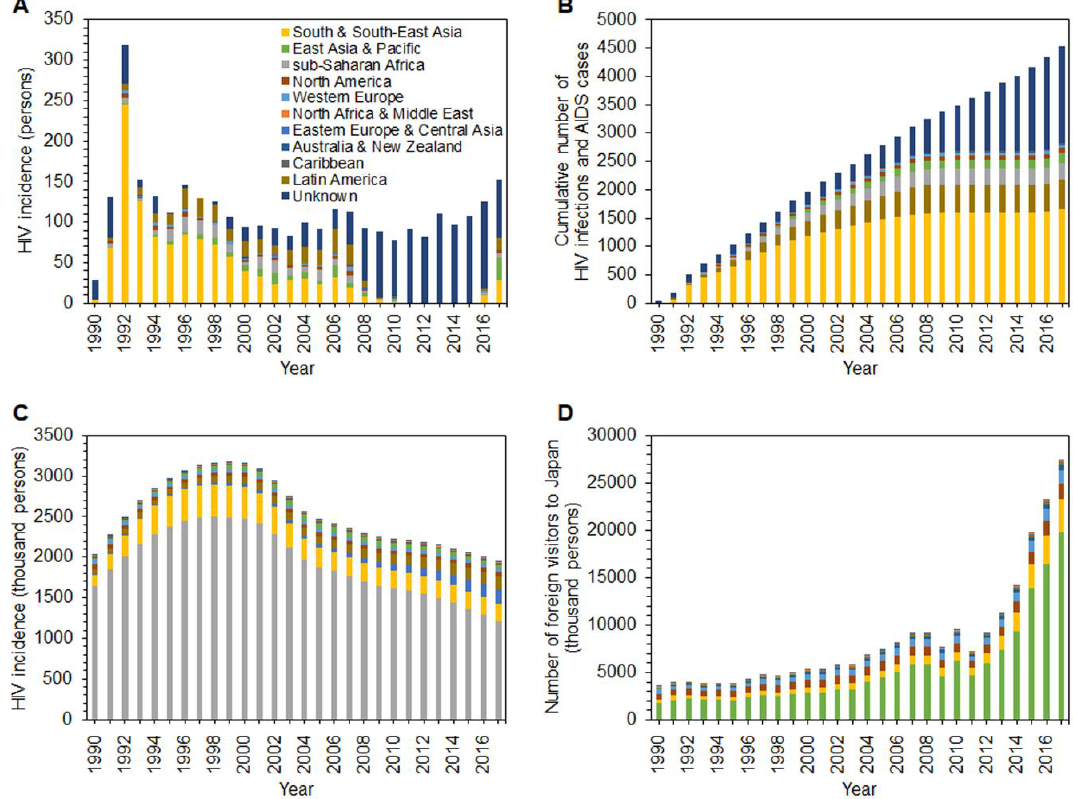
Figure 1. Human immunodeficiency virus (HIV) and nationality in Japan and worldwide, 1990–2017. ( A ) Yearly incidence (i.e., the number of new infections) of HIV among foreign residents in Japan. ( B ) Cumulative number of HIV infections and acquired immunodeficiency syndrome (AIDS) cases among foreign residents in Japan. ( C ). Estimated yearly incidence of HIV infections in the home country, by region (as estimated by the Institute of Health Metrics and Evaluation). ( D ) Temporal distribution of the yearly number of foreign visitors to Japan, by region of the country of origin.